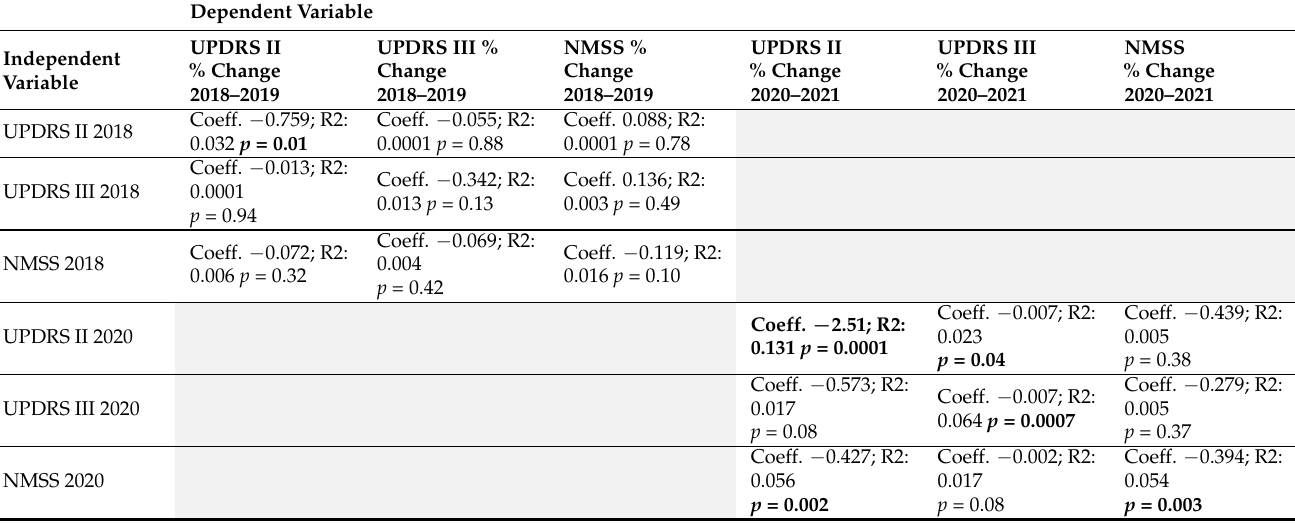
Table 3. Results of the simple regression analysis matching %changes observed in 2018–2019 and 2020–2021 in the primary outcome measures with their starting values. Statistically significant correlations are in bold.